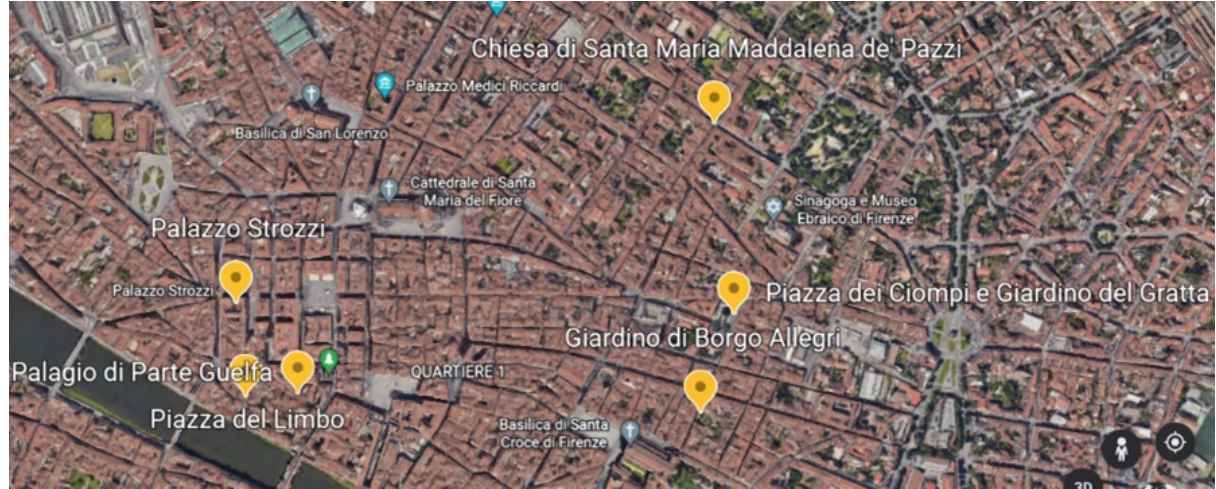
Figure 1: Localization of study cases in